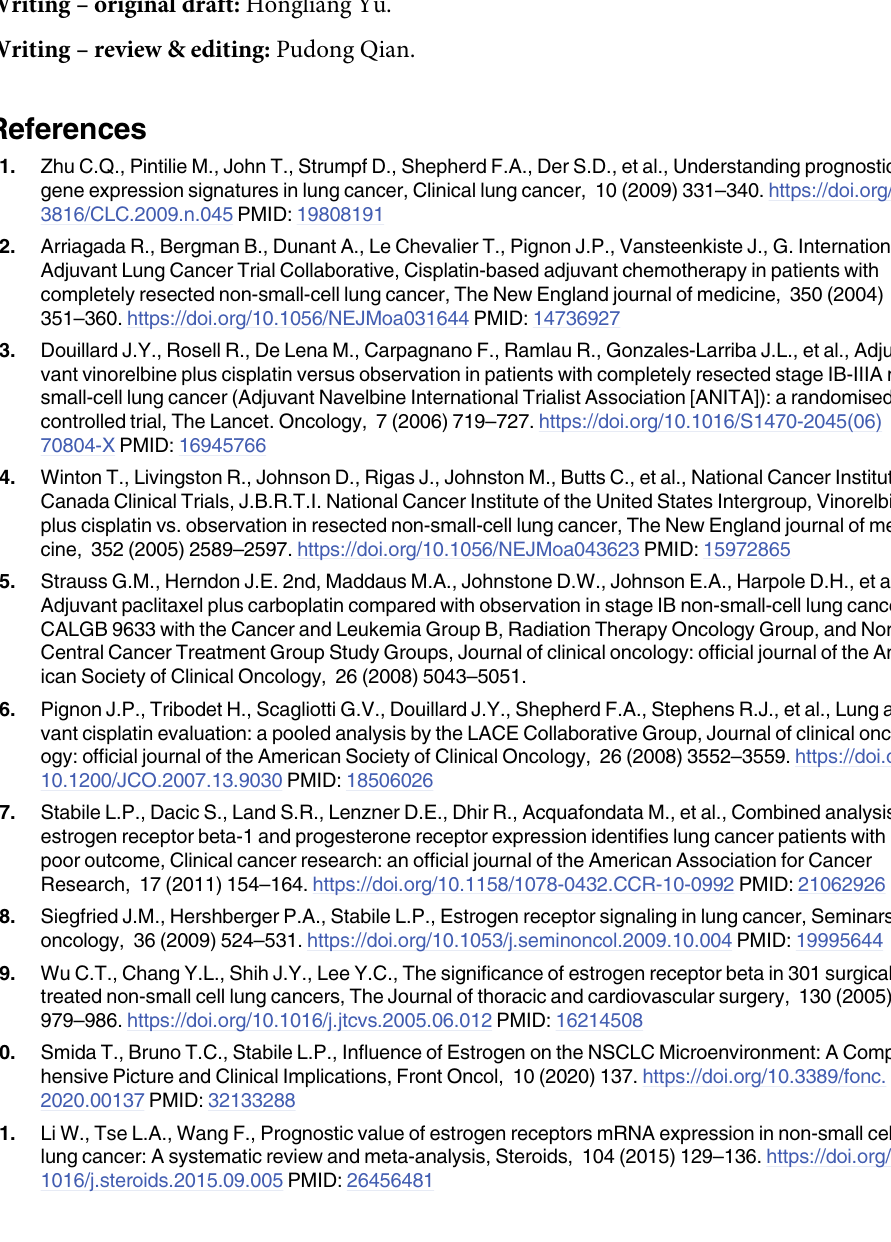
S1 Fig. ESR2 interacts with signature genes of the two original